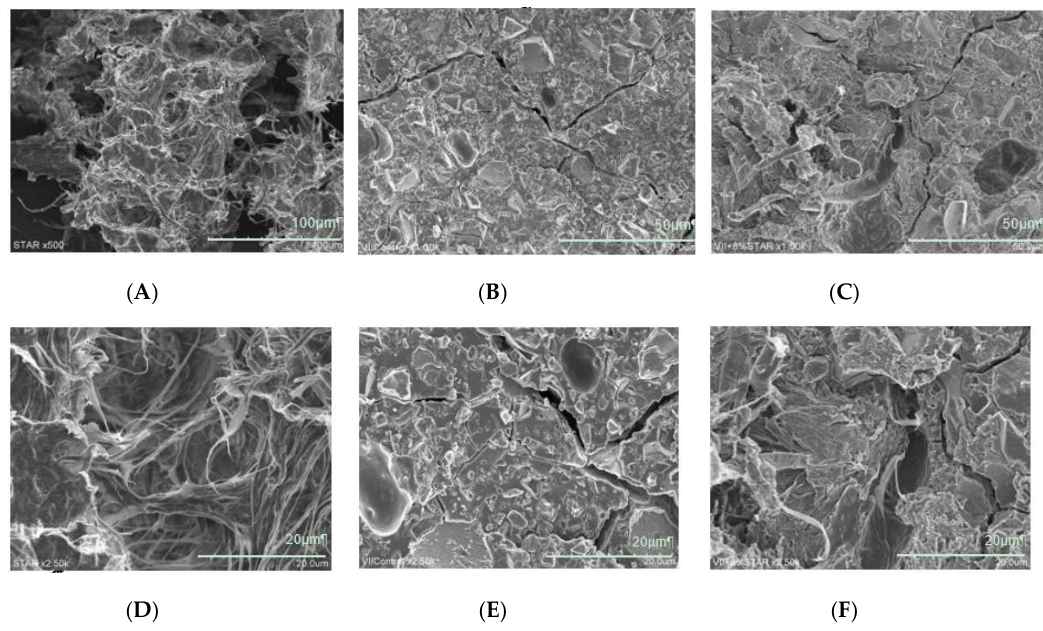
Figure 1. SEM images of STAR (( A ) ×500 and ( D ) ×2500), control GIC (( B ) ×1000 and ( E ) ×2500) and 8% STAR-containing GIC (( C ) ×1000 and ( F ) ×2500) samples.